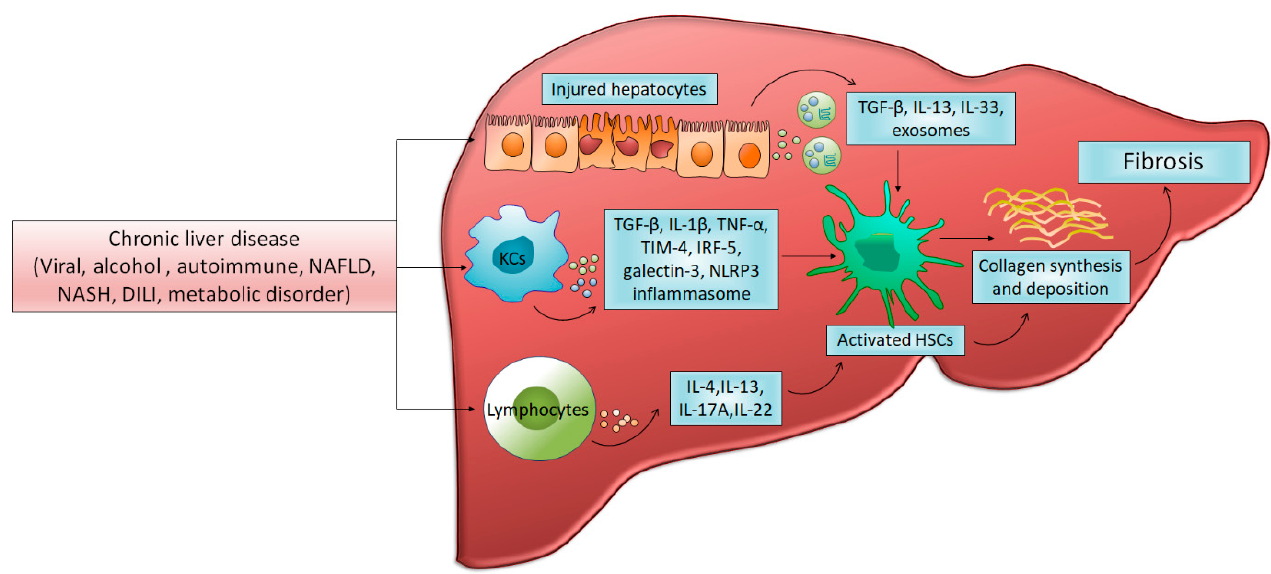
Figure 1. Mechanisms of liver fibrosis. Chronic liver injury mediated by different factors activates several parenchymal and non-parenchymal cells and induce cellular and molecular pathways that encourage hepatic inflammation by producing numerous inflammatory mediators. Extreme inflammation drives hepatic stellate cells activation, which then transform into proliferative and extracellular matrix producing myofibroblast leading to fibrosis and hepatic dysfunction. NAFLD: Non-alcoholic fatty liver disease, NASH: non-alcoholic steatohepatitis, DILI: drug-induced liver injury, KCs: kupffer cells, TGF- β : transforming growth factor beta, TNF- α : tumor necrosis factor alpha, TIM-4: T cell immunoglobulin and mucin-4, IRF-5: interferon regulatory factor-5, NLRP3: NLR family pyrin domain containing 3, HSC: hepatic stellate